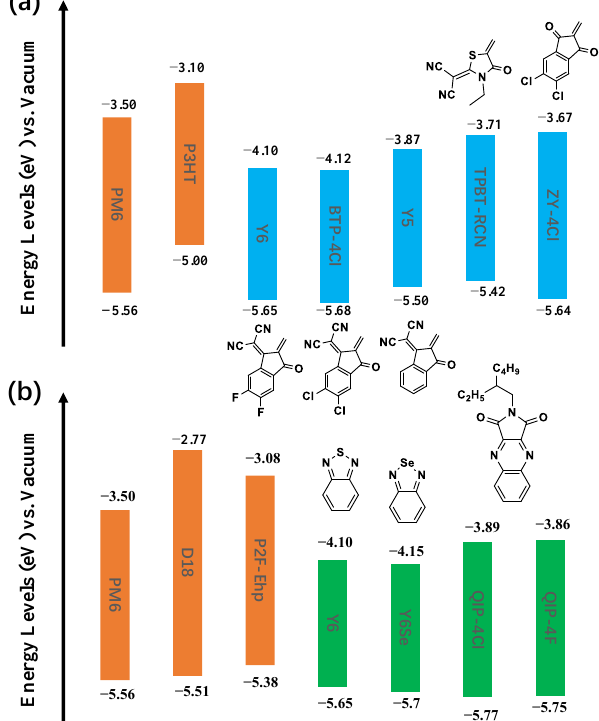
Figure 5. Frontier molecular orbits when ( a ) altering flanking units and ( b ) nucleus in the middle. Data from Refs. [20,21,65 – 68].